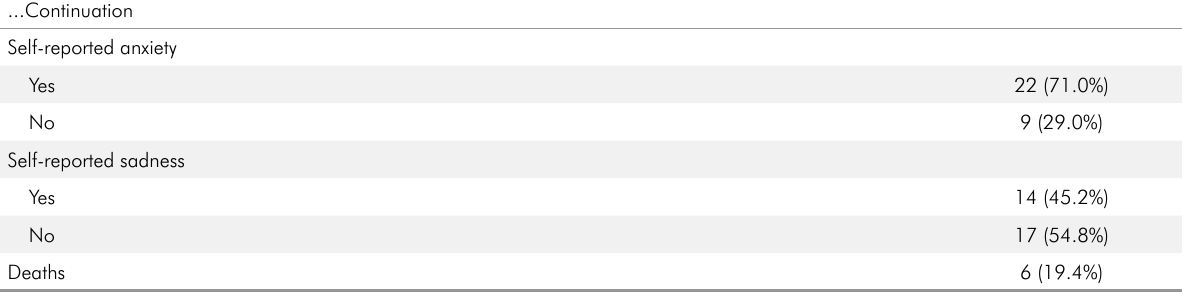
Table 2. Characteristics of HNC patients with delayed follow-up consultation or palliative care during COVID-19 pandemic. Variable